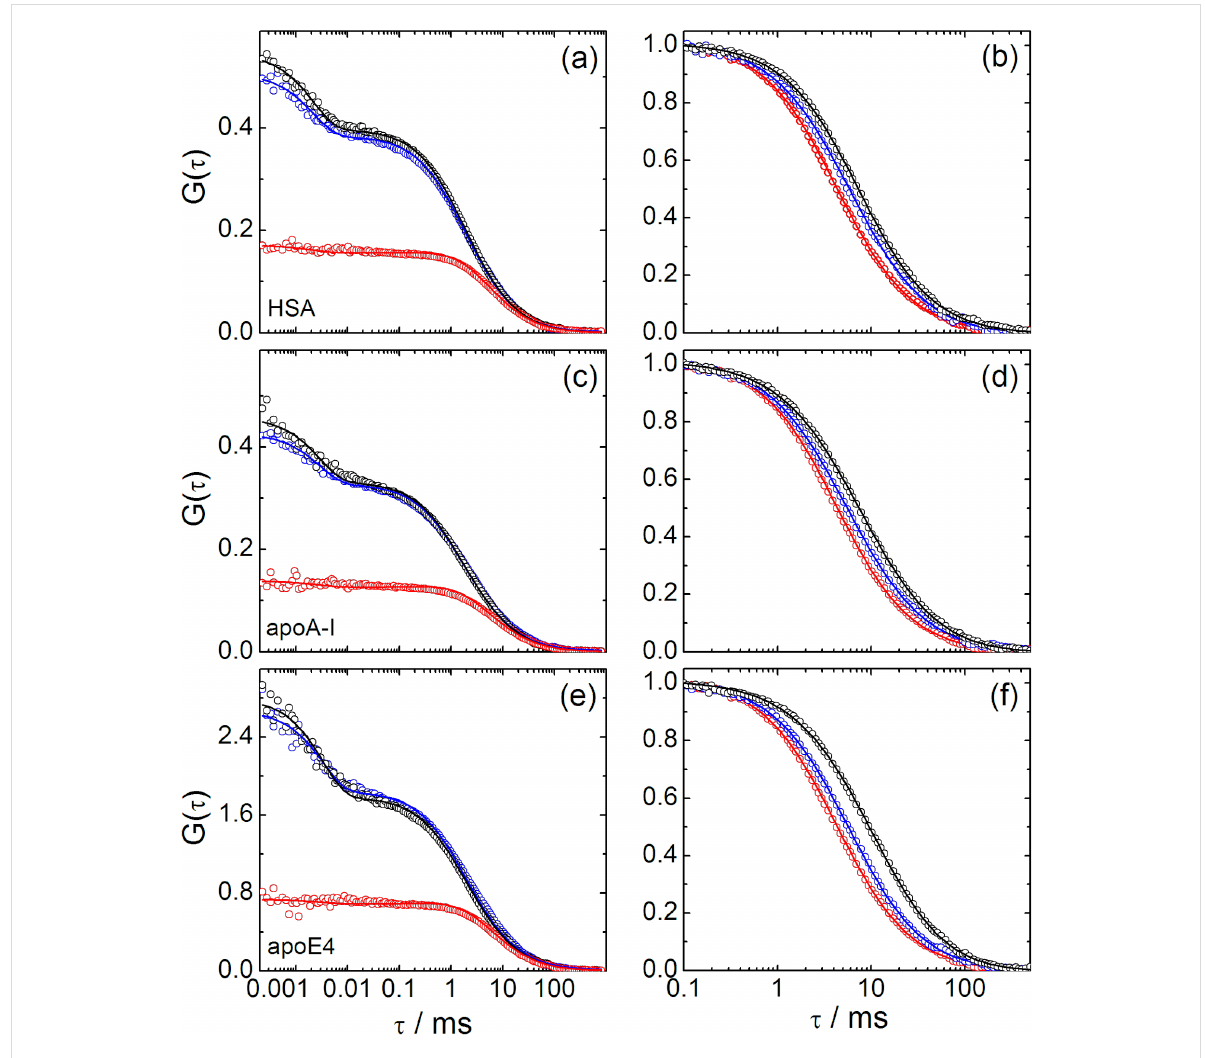
Figure 1: Fluorescence intensity correlation curves of NPs dissolved in buffer solutions of (a, b) HSA, (c, d) apoA-I, and (e, f) apoE4. (a, c, e) Measured (symbols) and fitted (lines) 2fFCS autocorrelation (black and blue) and cross-correlation (red) functions of polymer-coated FePt NPs in the presence of (a) 400 µM HSA, (c) 285 µM apoA-I and (e) 7.2 µM apoE4. (b, d, f) Measured (symbols) and fitted (lines) cross-correlation curves of NPs in buffer solution (red) and in the presence of serum proteins at two concentrations, normalized to 1 at τ = 0.1 ms. (b) 6.3 and 400 µM HSA (blue, black); (d) 36 and 285 µM apoA-I (blue, black); (f) 14 nM and 7.2 µM apoE4 (blue, black).